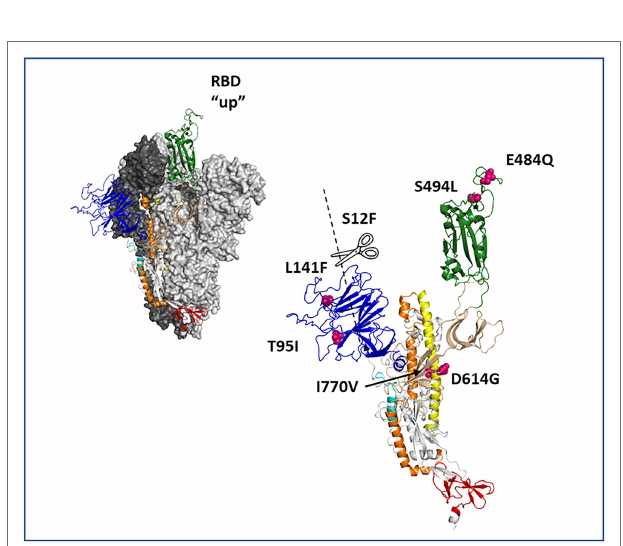
FIGURE 2 | Protein depiction of the spike homotrimer in open conformation. The residues involved in amino acid substitutions are pointed in the structure